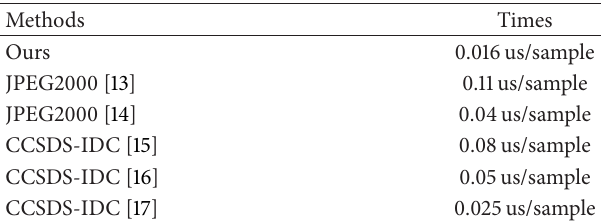
Table 3: The results of complexity